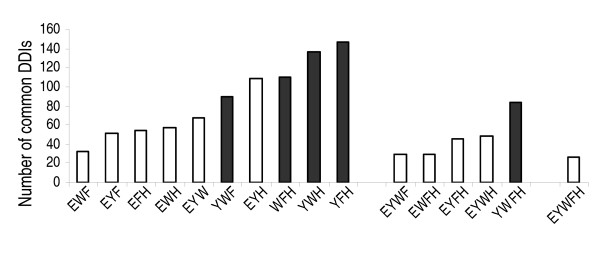
Interacting domain pairs shared by several organisms. The histogram shows the number of DDIs shared by three, four, and all five organisms. White bars represent DDIs that are used also in E. coli and black bars represent DDIs common only to the eukaryotes in our study. Twenty-seven DDIs were shared by all five organisms. E: E. coli. Y: yeast (S. cerevisae). W: worm (C. elegans). F: fly (D. melanogaster). H: human. DDI, domain-domain interaction.